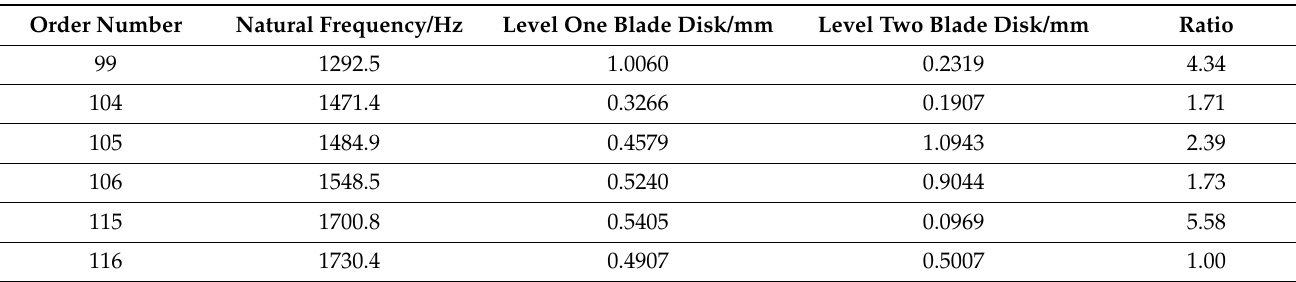
Table 10. Maximum displacement and ratio of the vibration of the Stage 1 and Stage 2 bladed disk systems. Order